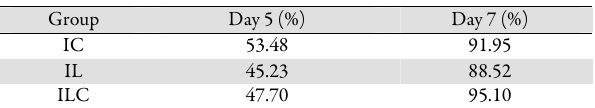
Table 2. Percentage chemo-suppression of parasite multiplication in